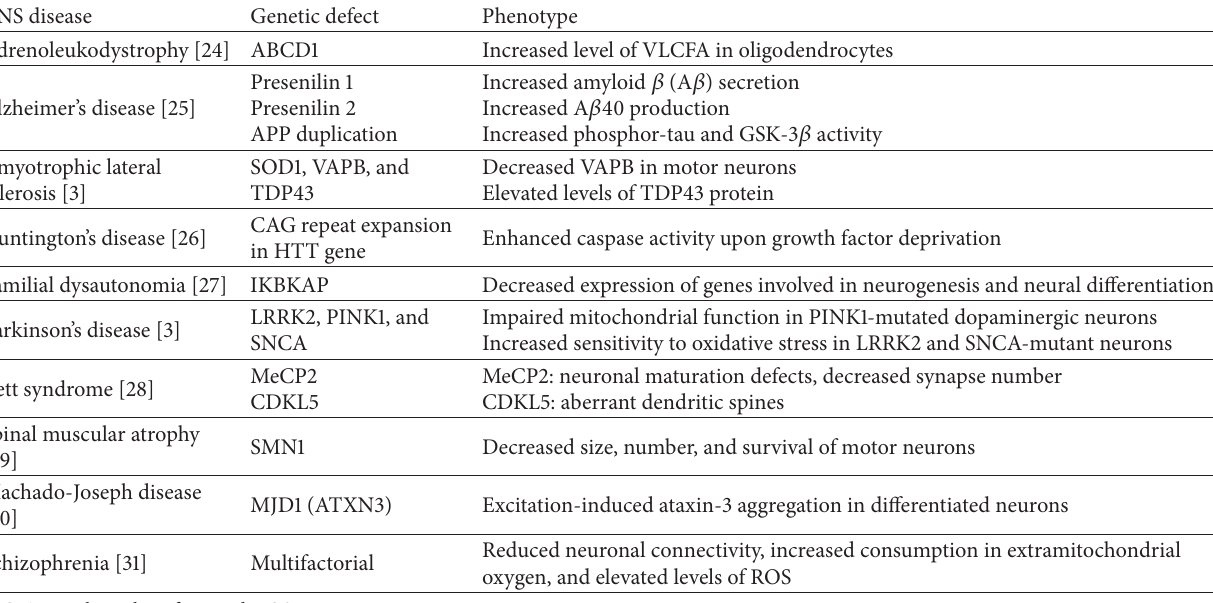
Table 1: Neurodegenerative specific iPSC for disease modelling.